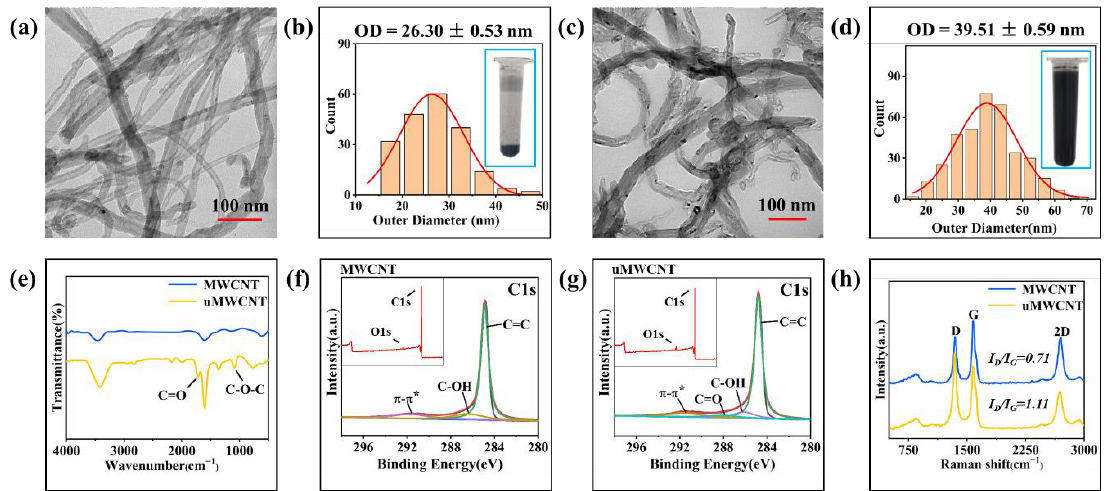
Figure 1. TEM image ( a ) and outer diameter distribution ( b ) of MWCNTs; TEM image ( c ) and outer diameter distribution ( d ) of uMWCNTs; ( e ) FT-IR spectra of MWCNTs and uMWCNTs; ( f ) XPS spectrum of MWCNTs; ( g ) XPS spectrum of uMWCNTs; ( h ) Raman spectra of MWCNTs and uMWCNTs.